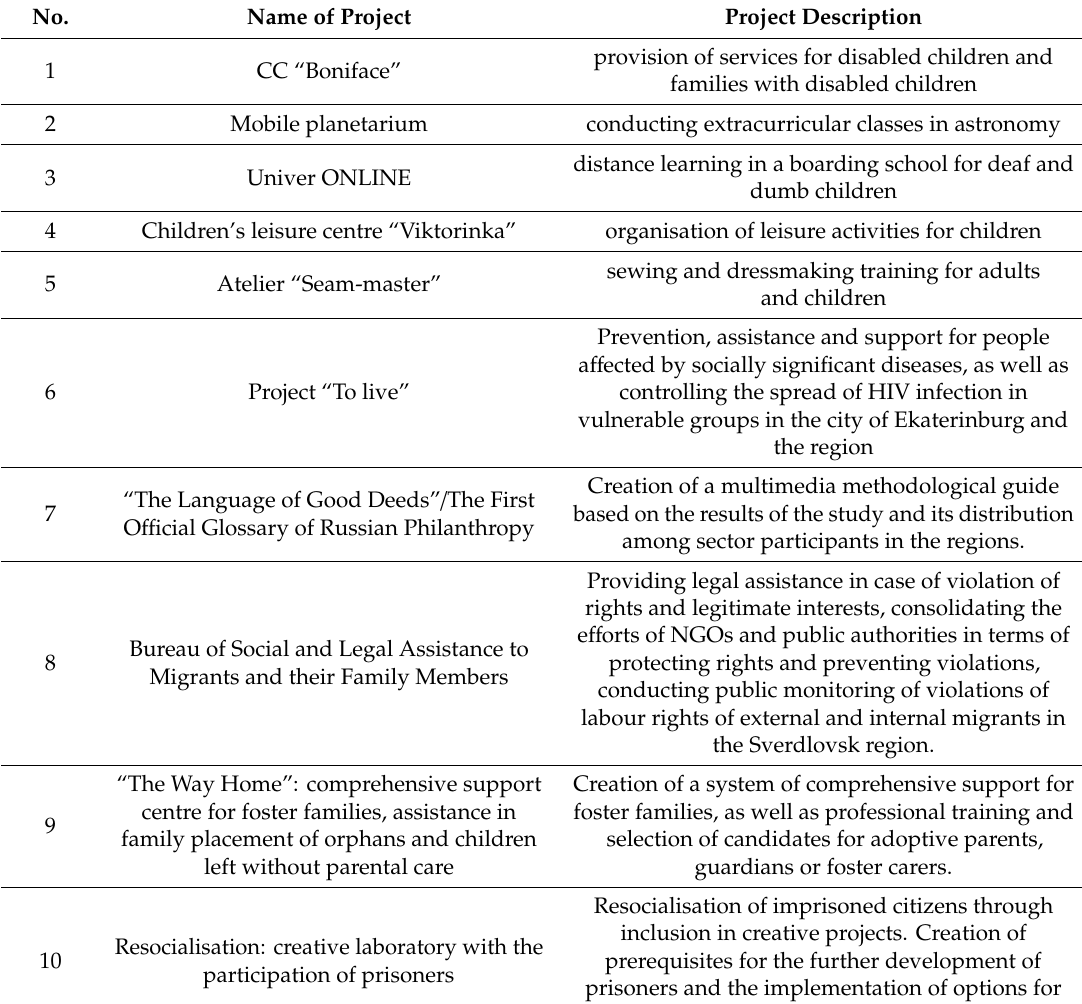
Table 5. Description of social